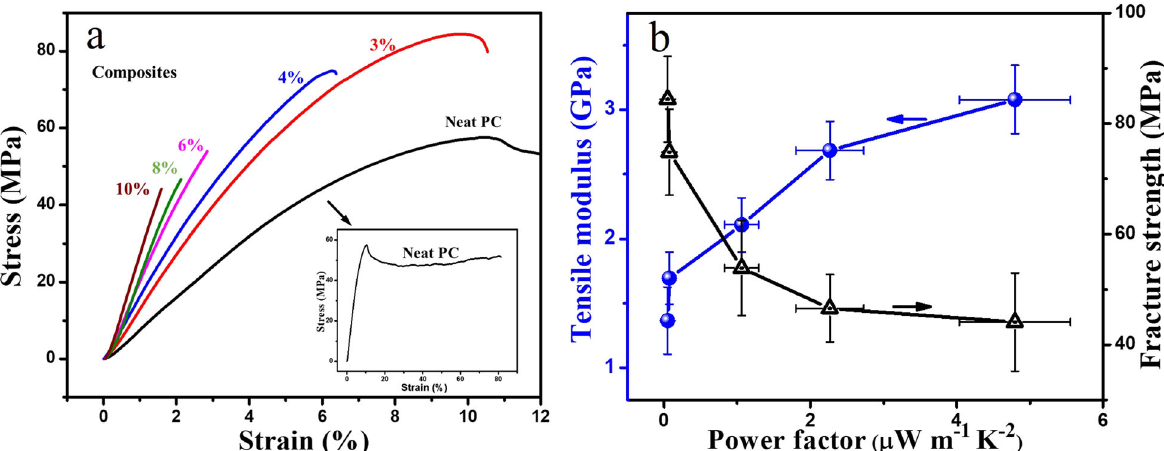
Fig. 3 The mechanical property of TE composites. a Typical stress-strain curves of PC/a-SWCNT fi lms in the aligned direction as a function of SWCNT contents; The inset shows the whole stress-strain curve of neat PC for comparison. b The mechanical properties versus the power factor for PC/a-SWCNT fi lms. Error bars represent standard deviation with n ≥ 5 for each